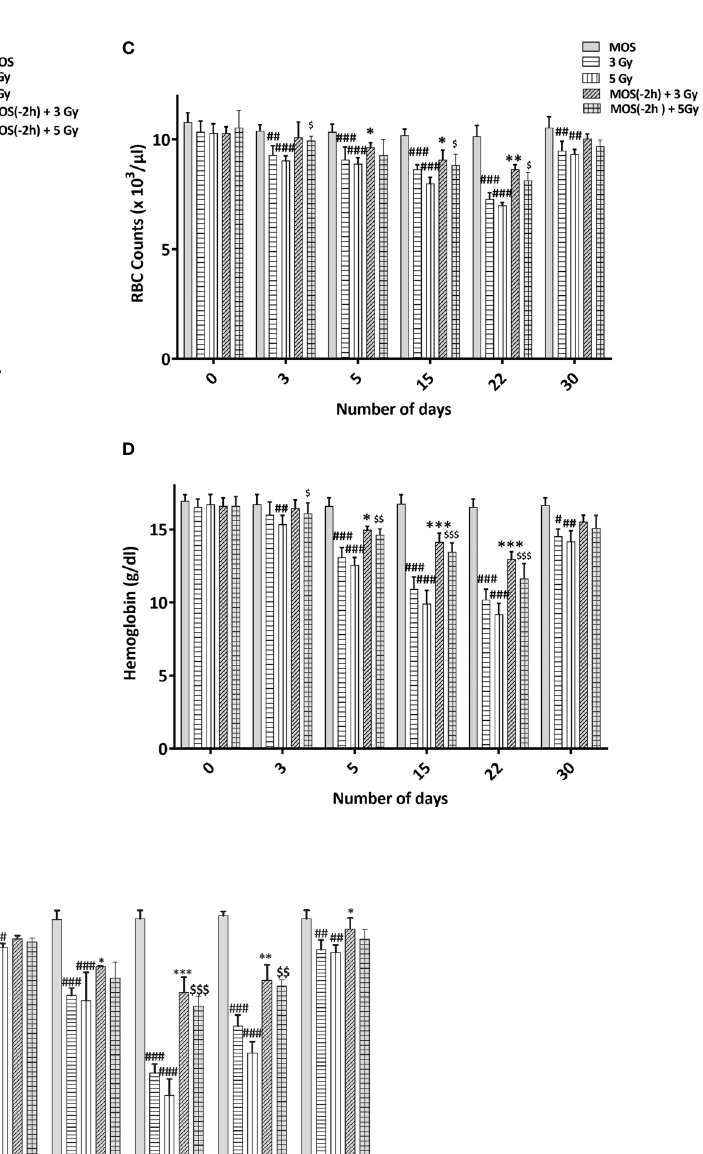
Figure 5D . The average cells per crypt of jejunum in the untreated control were about 35.5 ± 2.32. MOS treatment alone